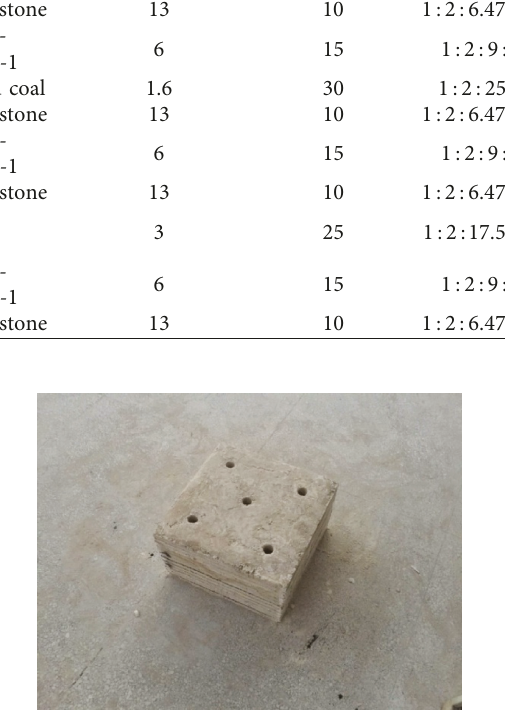
Figure 3: The layered concrete test block ready for